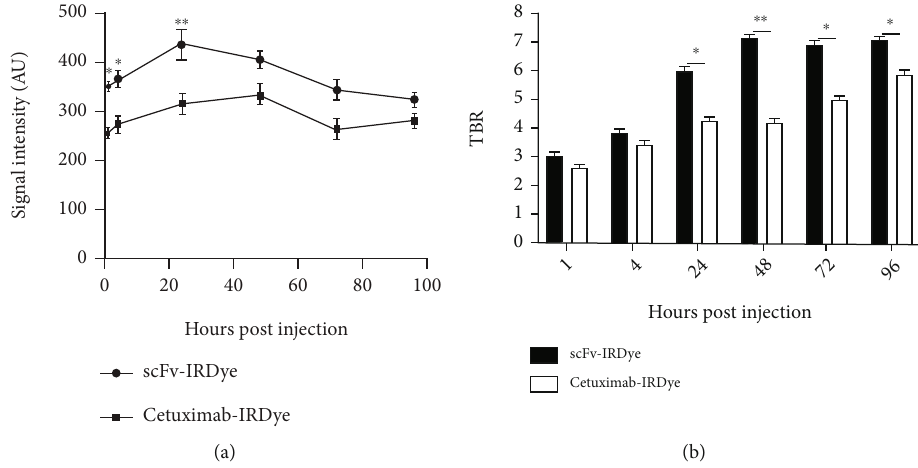
Figure 5: NIR fl uorescence analysis of IRDye800CW-conjugated molecules after applying on A-431 tumor-bearing mice. (a) Intensity of fl uorescent signals emitting from tumor tissues. (b) Tumor-to-background ratio analysis. Error bars represent mean ± standard deviation . The asterisks indicate signi fi cant di ff erences between groups ( ∗ p < 0 : 05 , ∗∗ p < 0 : 01